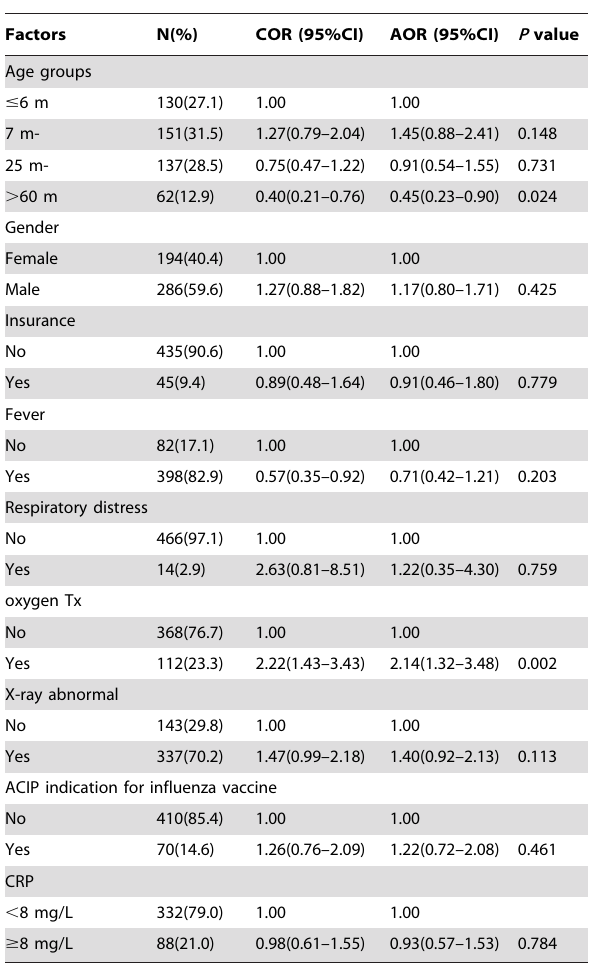
Table 3. Analysis of potential risk factors for the length of hospitalization of influenza positive children in Suzhou Children